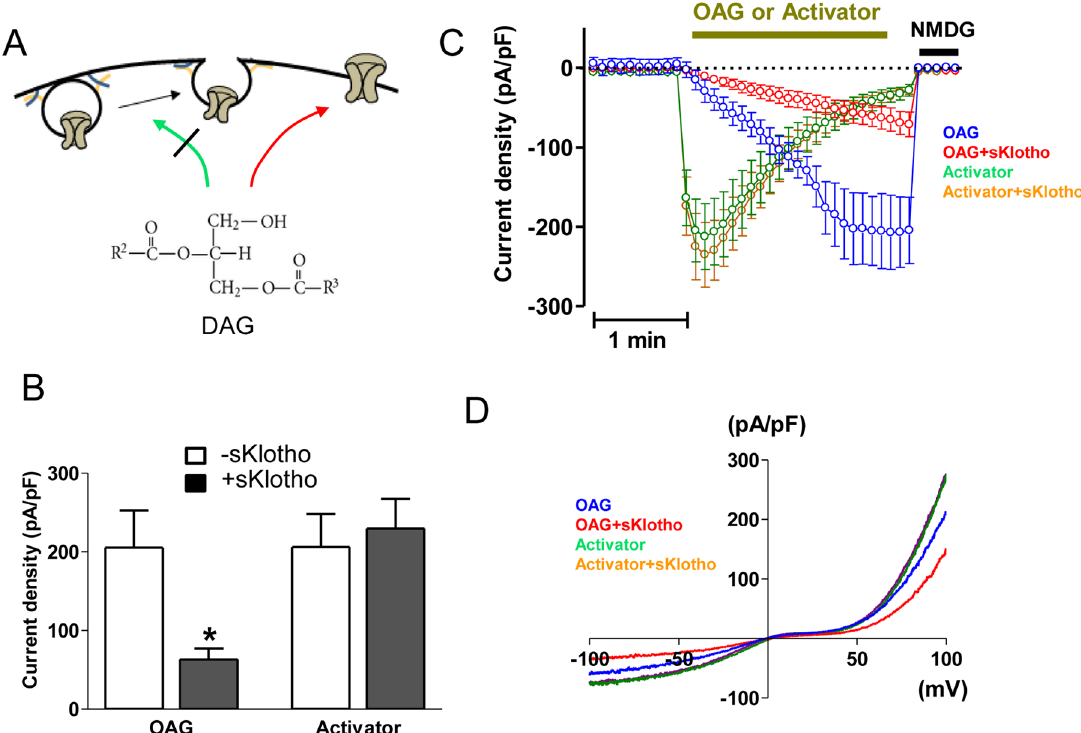
Fig 2. Soluble klotho selectively blocks DAG-stimulated TRPC6 exocytosis. (A) Diagram illustrating sKlotho selectively blocks exocytosis. (B-D) Effect of sKlotho on TRPC6 currents stimulated by BIRA0411XX or by OAG. HEK cells expressing recombinant TRPC6 channels were treated with sKlotho or vehicle overnight. TRPC6 currents were activated by BIRA0411XX (labeled as “activator”) or OAG. Panel B shows representative current-voltage (I-V) relationship curve. Panel C shows time course of TRPC6 currents. Panel D shows mean ± SEM (n = 6–8 each) of peak inward current density from multiple experiments. Please note that the I-V curve of “activator + sKlotho” (orange line) essentially overlaps with that of “activator” alone (green